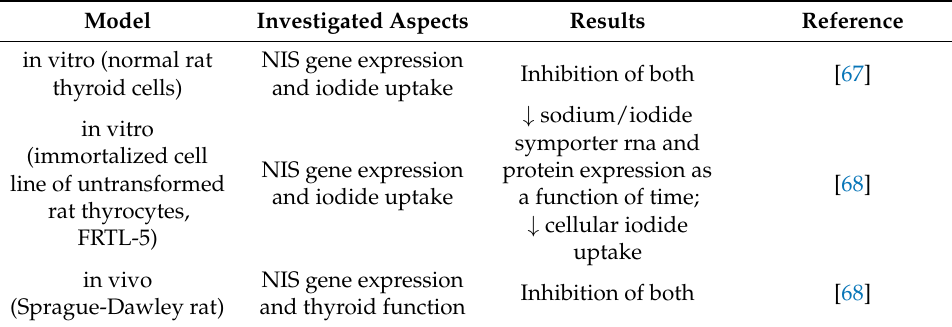
Table 6. In vivo and in vitro effects of resveratrol treatment.